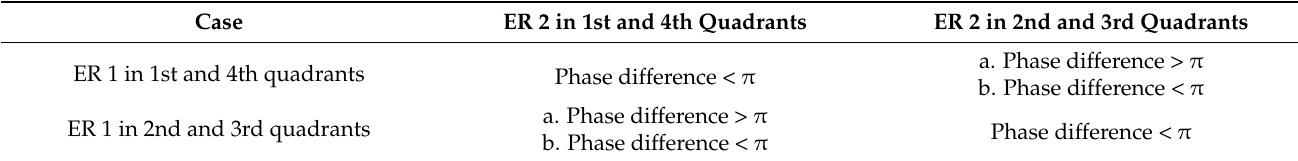
Table 2. Change domain of the phase difference.